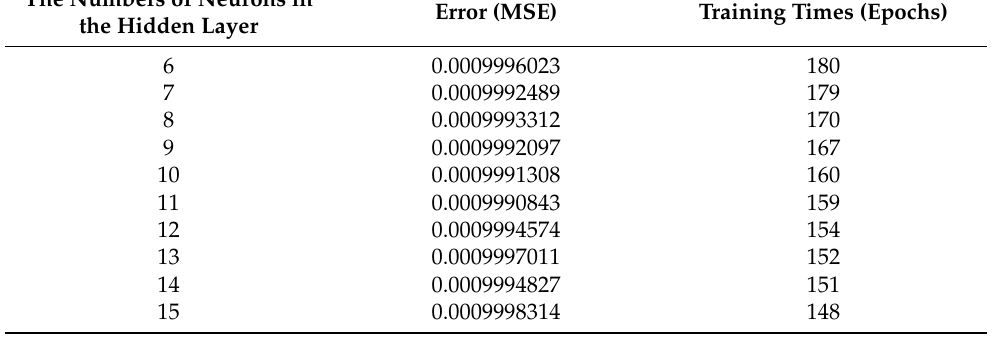
Table 4. Comparison of network performance with different numbers of neurons in the hidden layer.